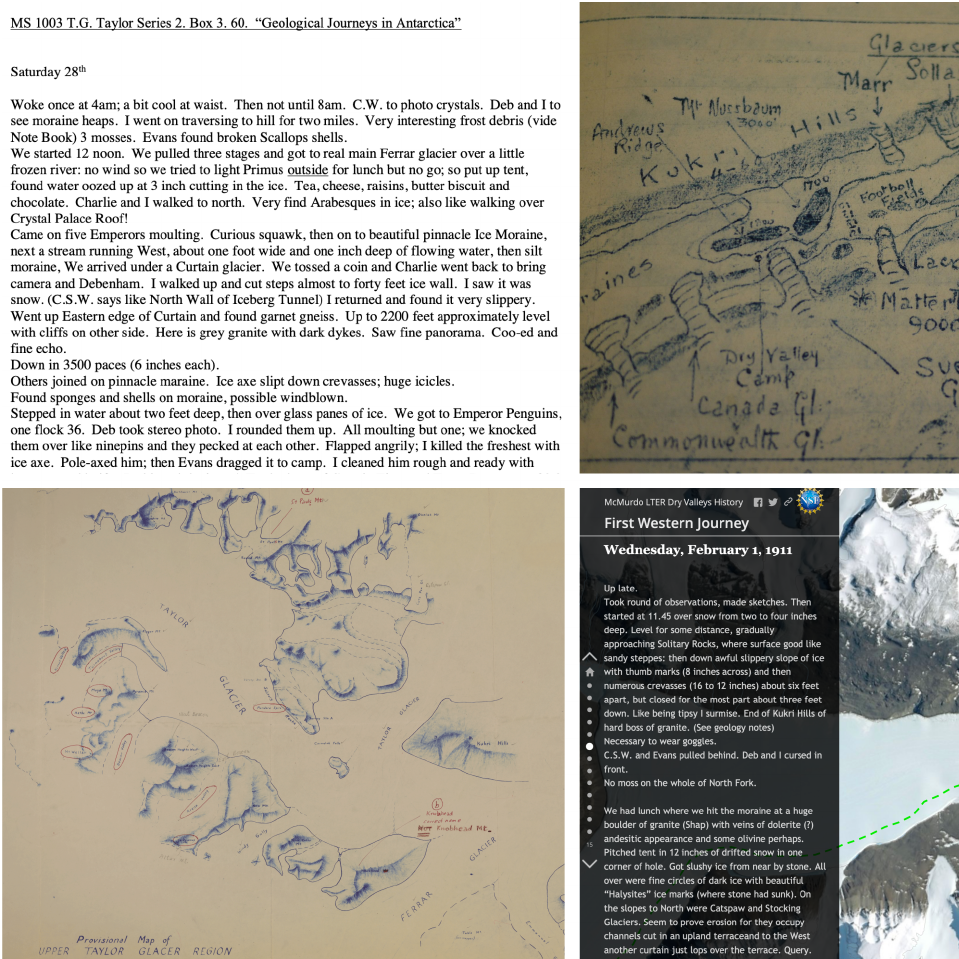
Figure 2. Examples of non-photographic data available in the archive. Unless otherwise stated, copyright for each item remains with the respective contributor. Detailed metadata for each item are available on the archive website (http://mcmurdohistory.lternet.edu) and from the Environmental Data Initiative (Howkins et al.,